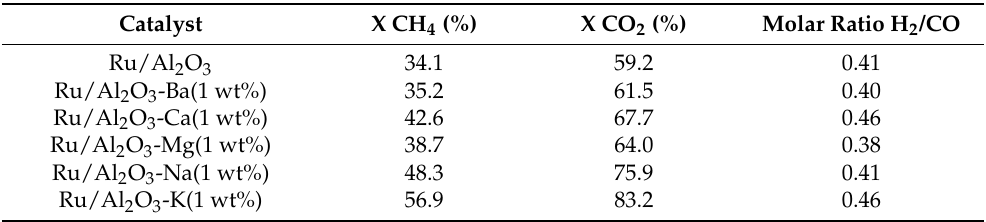
Table 3. % CH 4 conversion, % CO 2 conversion, and H 2 /CO molar ratio for Ru/Al 2 O 3 -A/AE(1 wt%) catalysts (750 ◦ C, 135 min reaction time). Catalyst weight: 50